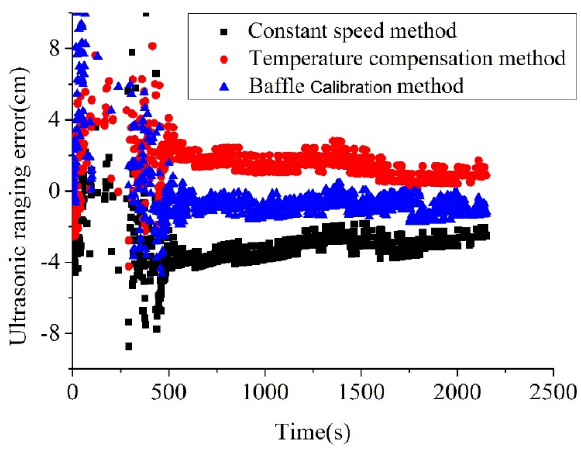
Figure 13. Measurement errors of the three methods along the time. Table 4. Statistical analysis of measurement errors for the three methods.